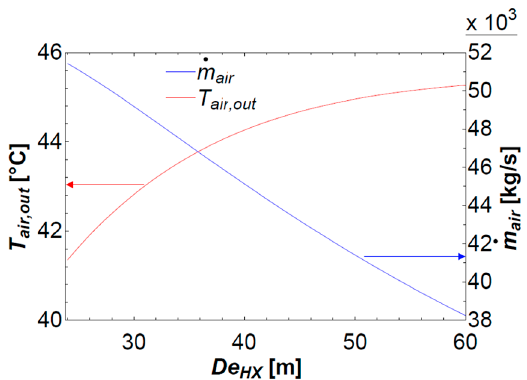
Figure 11. Air mass flow rate and condenser outlet air temperature change with condenser depth.